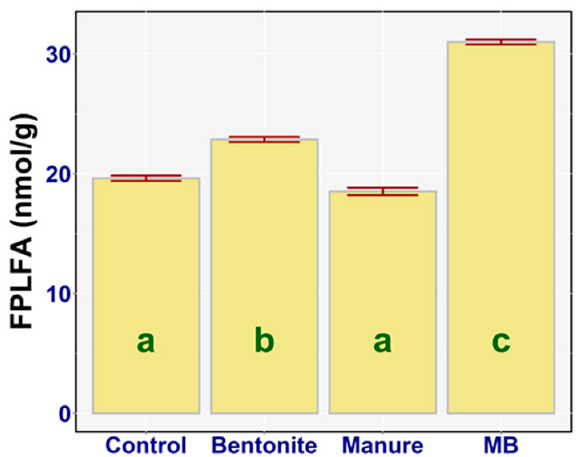
Figure 5. Amount of FPLFA (nmol/g) in the treatments: means with SEM.